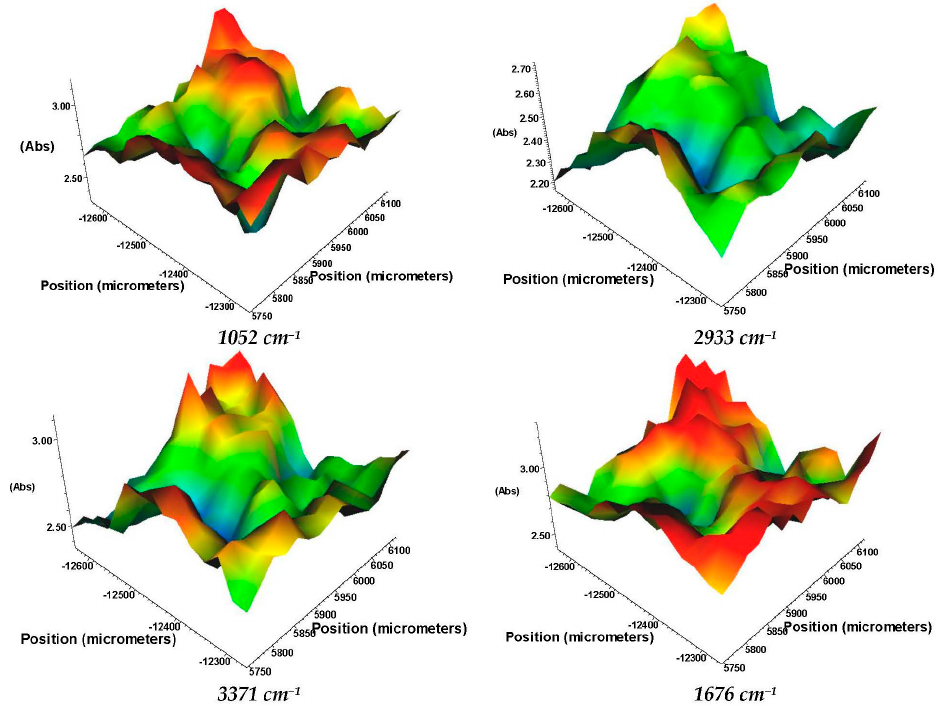
Figure 3. InfraRed maps of the 3D anti-infective regeneration matrix (e.g., 3D-1:1).